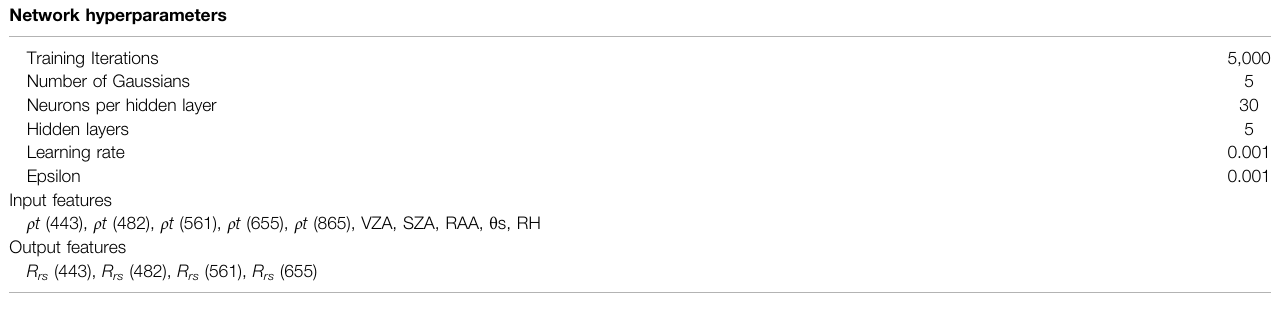
TABLE 2 | Properties of MDNs used for developing our experimental AC processors. Network hyperparameters Training Iterations